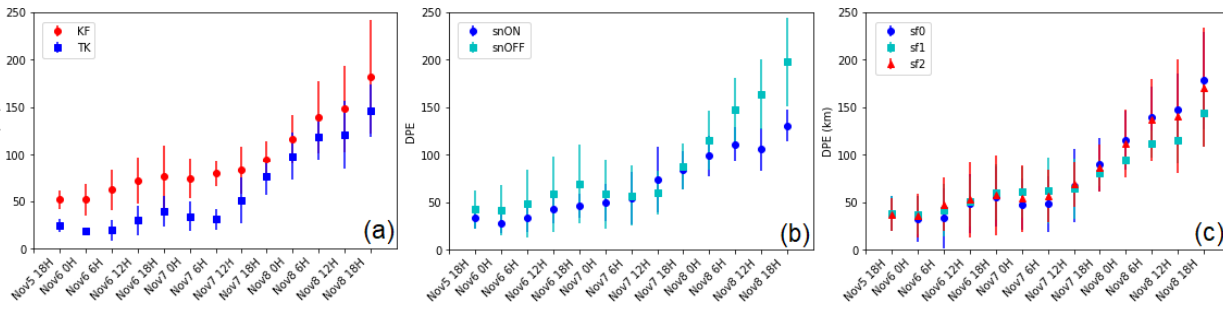
Figure 3. Mean and standard deviation of the DPE (km) per simulation group – (a) for the cumulus schemes KF and TK; (b) for with (snON) and without nudging (snOFF); and (c) for surface flux options sf0, sf1, and sf2. The x axis shows the analysis period between 18:000UTC on 5 November 2013 and 18:00UTC on 8 November